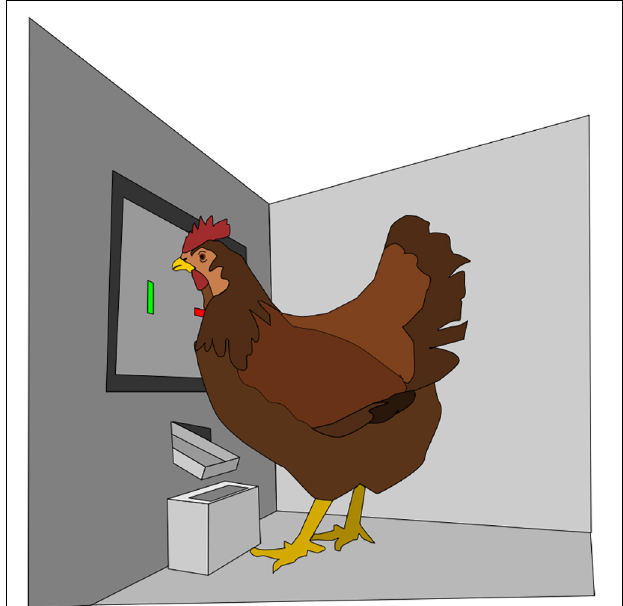
FIGURE 1 | Schematic illustration of the test box (width, depth, height: 55 cm × 46.5 cm × 66 cm). The black touchscreen (height × wide: 19 cm × 25 cm, diagonal: 31 cm) is on the back wall, displaying two different stimuli, the colored bars. Wheat grain rewards are delivered to a food trough (height × wide × depth: 1.5 cm × 4 cm × 8 cm) below the screen. The walls are made out of clear